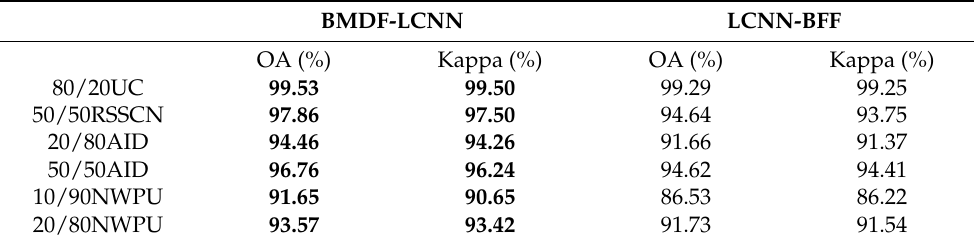
Table 1. Performance Comparison between LCNN-BFF and the Proposed